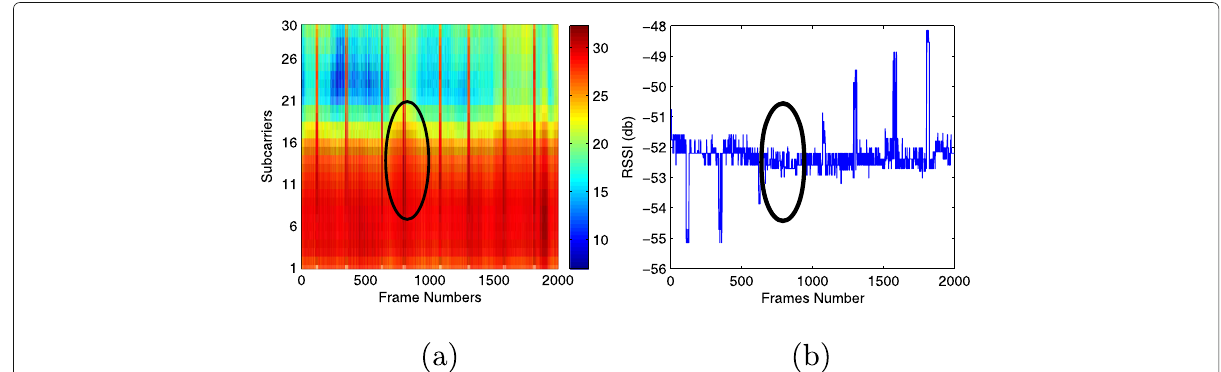
Fig. 4 The CSI amplitude ( a ) and RSS ( b ) for the received frames. The attacker injects the attacking frames every 300 frames with gradually increasing Tx-power